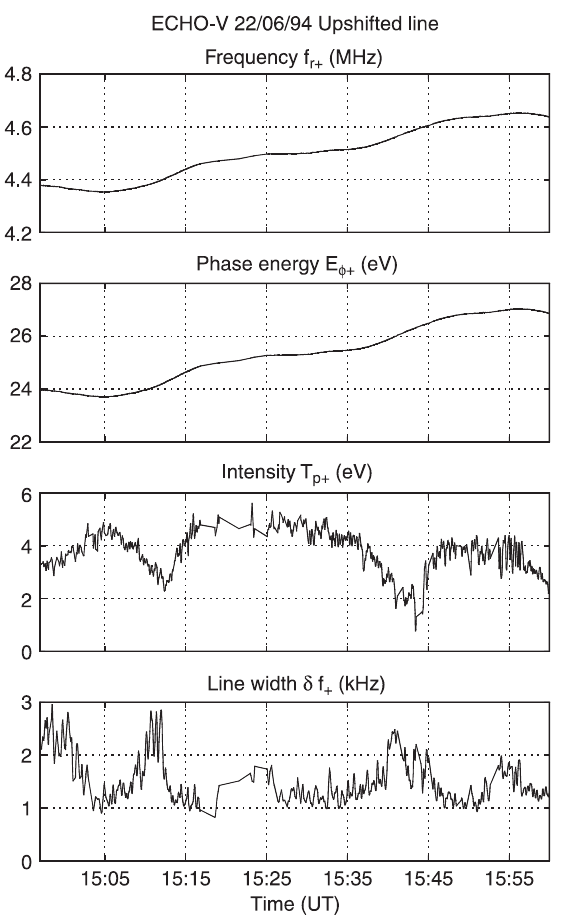
Fig. 4. The parameters extracted from the upshifted plasma line analysis for the 1-h period of observation. From top to bottom : the critical frequency f r (cid:135) , the corresponding phase energy E / (cid:135) , the intensity of the line (or plasma line temperature) T p (cid:135) and the line width d f (cid:135)